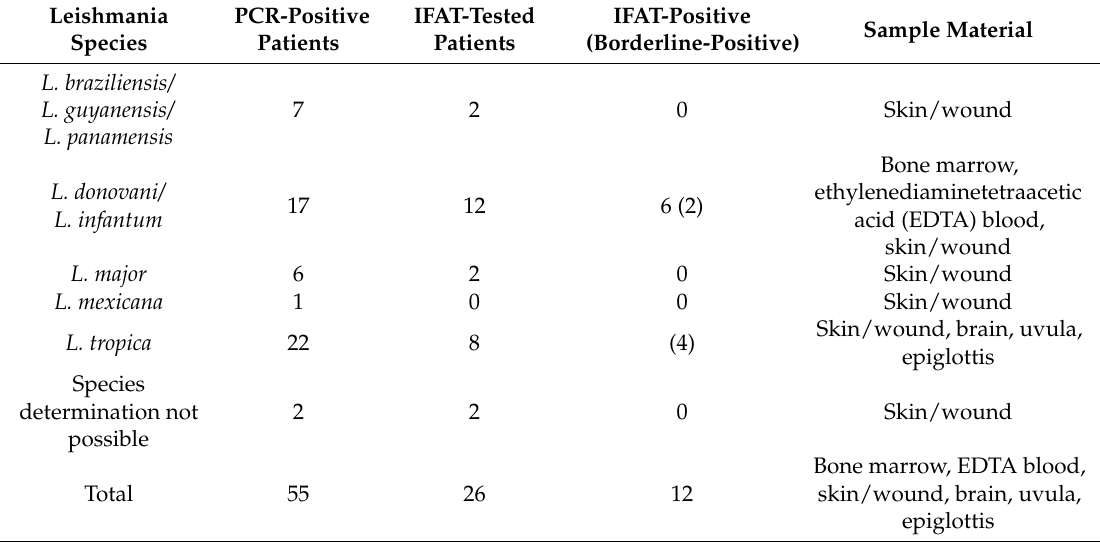
Table 1. Antibody test (IFAT) results according to Leishmania species, as confirmed by polymerase chain reaction (PCR) and the sample